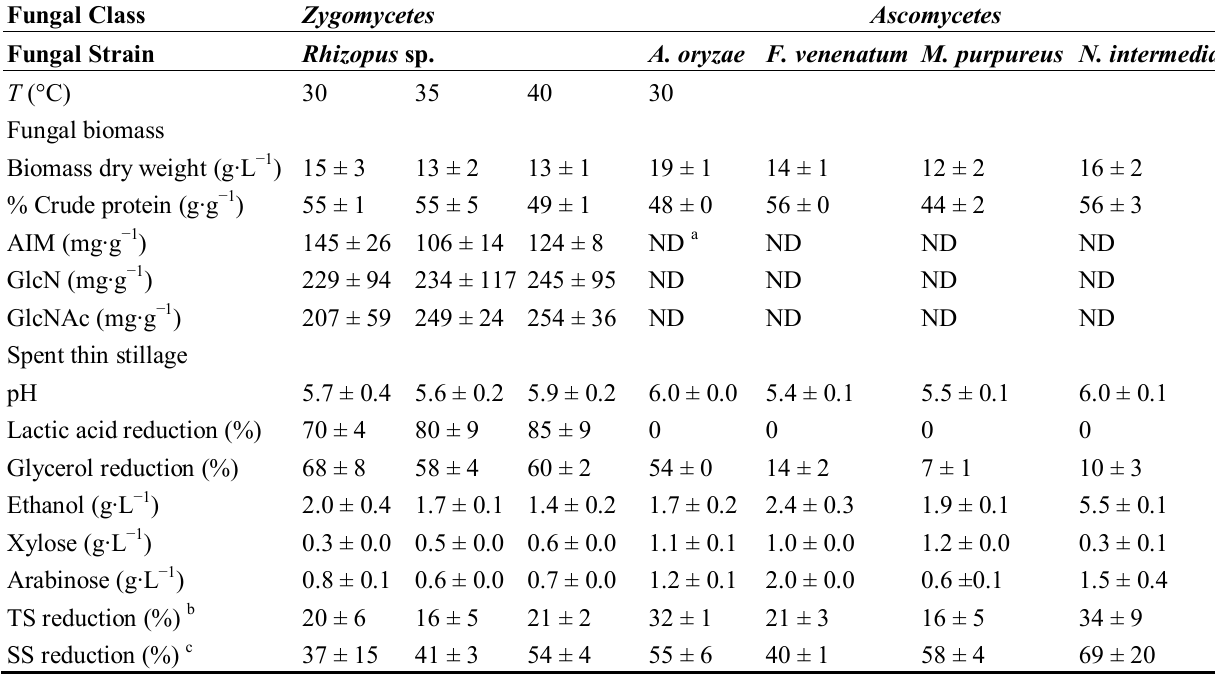
Table 2. Final biomass and spent thin stillage characteristics after 96 h and 72 h cultivation with Zygomycetes and Ascomycetes fungi,